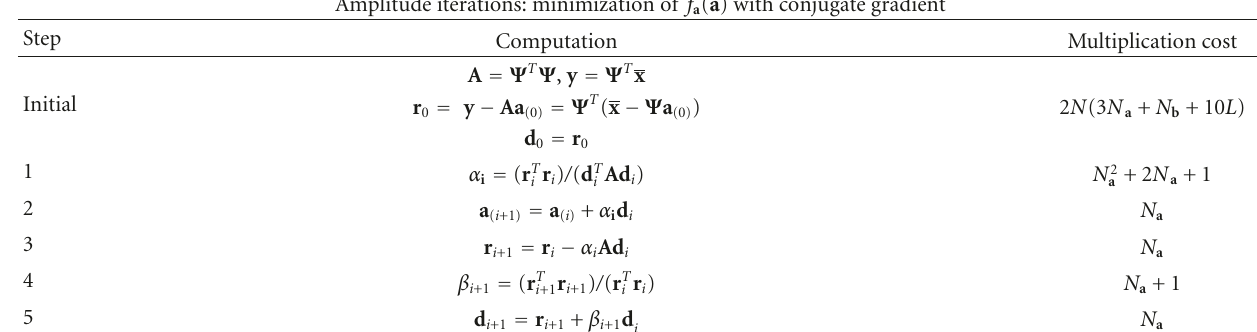
Table 4: Minimization of f a ( a ) with conjugate gradient